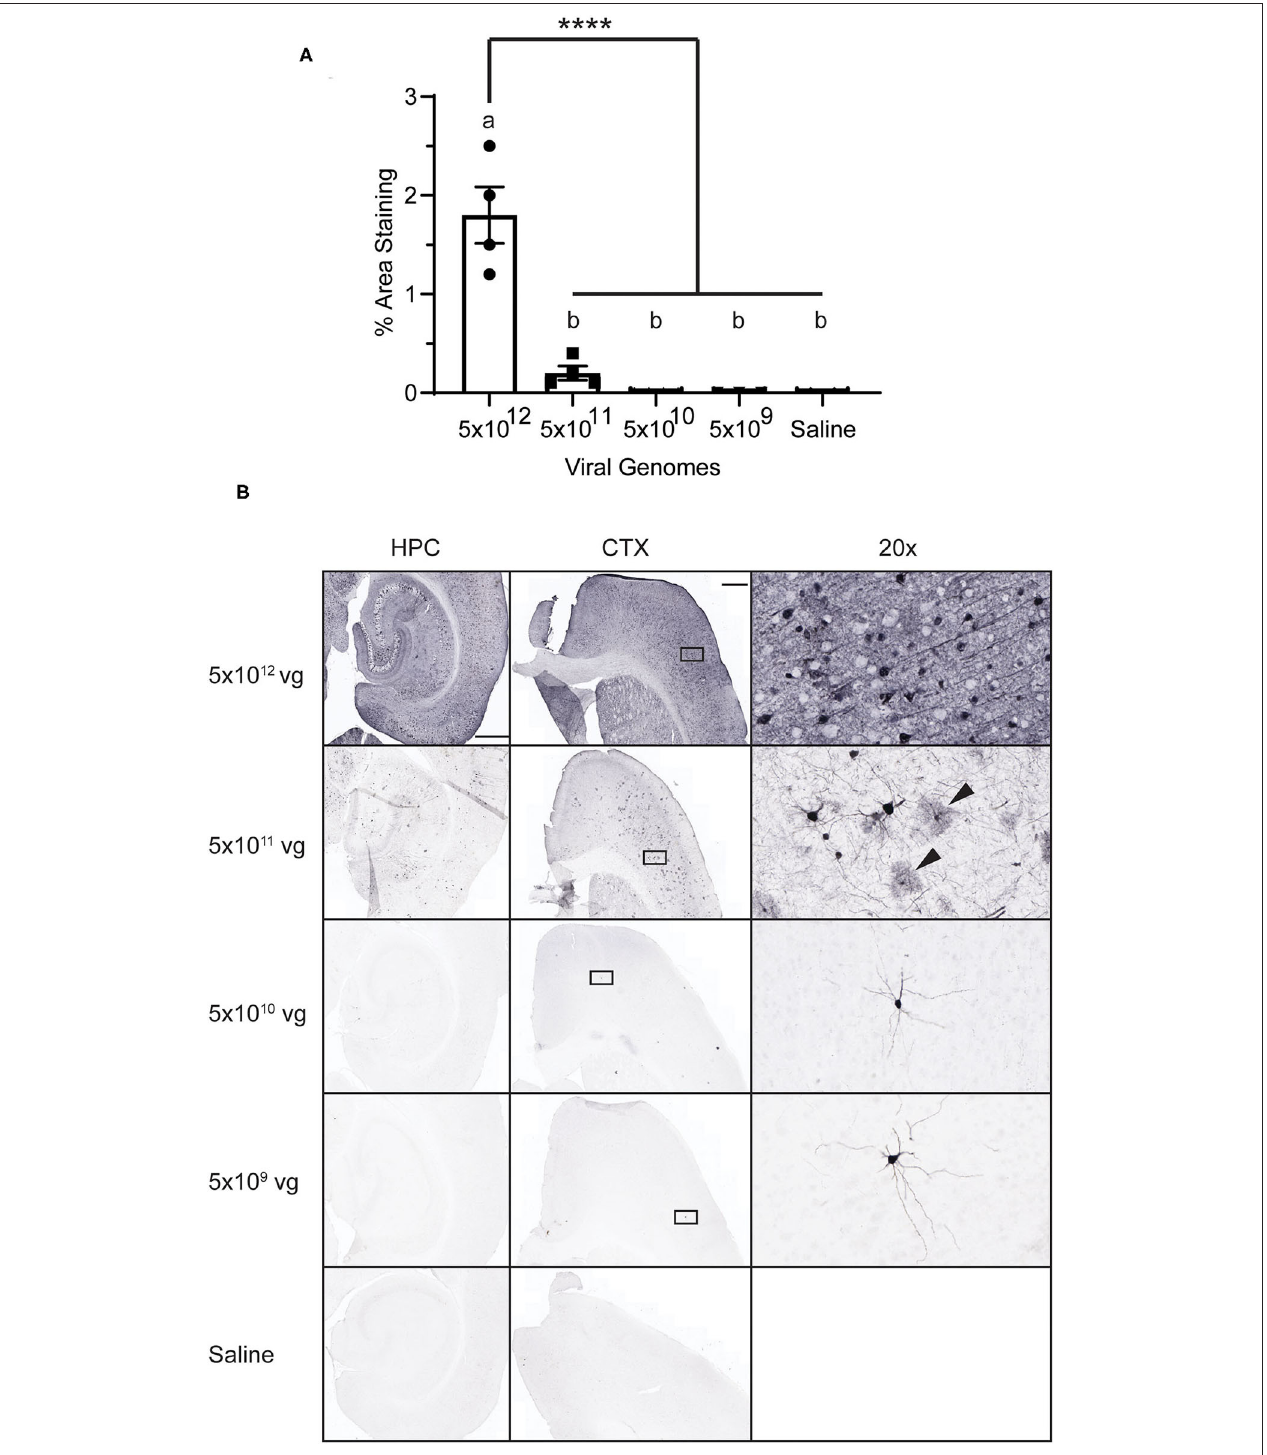
FIGURE 1 | AAV Dose-Response. Mice were injected with PHP.eB-CAG-GFP or saline and tissue was collected 4 weeks later. (A) Graph of percent area staining of GFP. Data points represent values for each mouse; mean ± SEM ( n = 3 for 5 × 10 9 vg; n = 4 for remaining groups) are indicated. **** denotes p < 0.0001 by one-way ANOVA and Tukey’s post-hoc test. Bars annotated with the same lower-case letter are not statistically different from each other. (B) Representative images with anti-GFP staining. Rectangles on the CTX panels indicate area enlarged on the right (20 × panels). Arrowheads indicate presumptive glial cells. CTX and HPC scale bar = 500 µ m, 20 × scale bar = 50 µ m. vg, viral genomes; CTX, cortex; HPC, hippocampus.